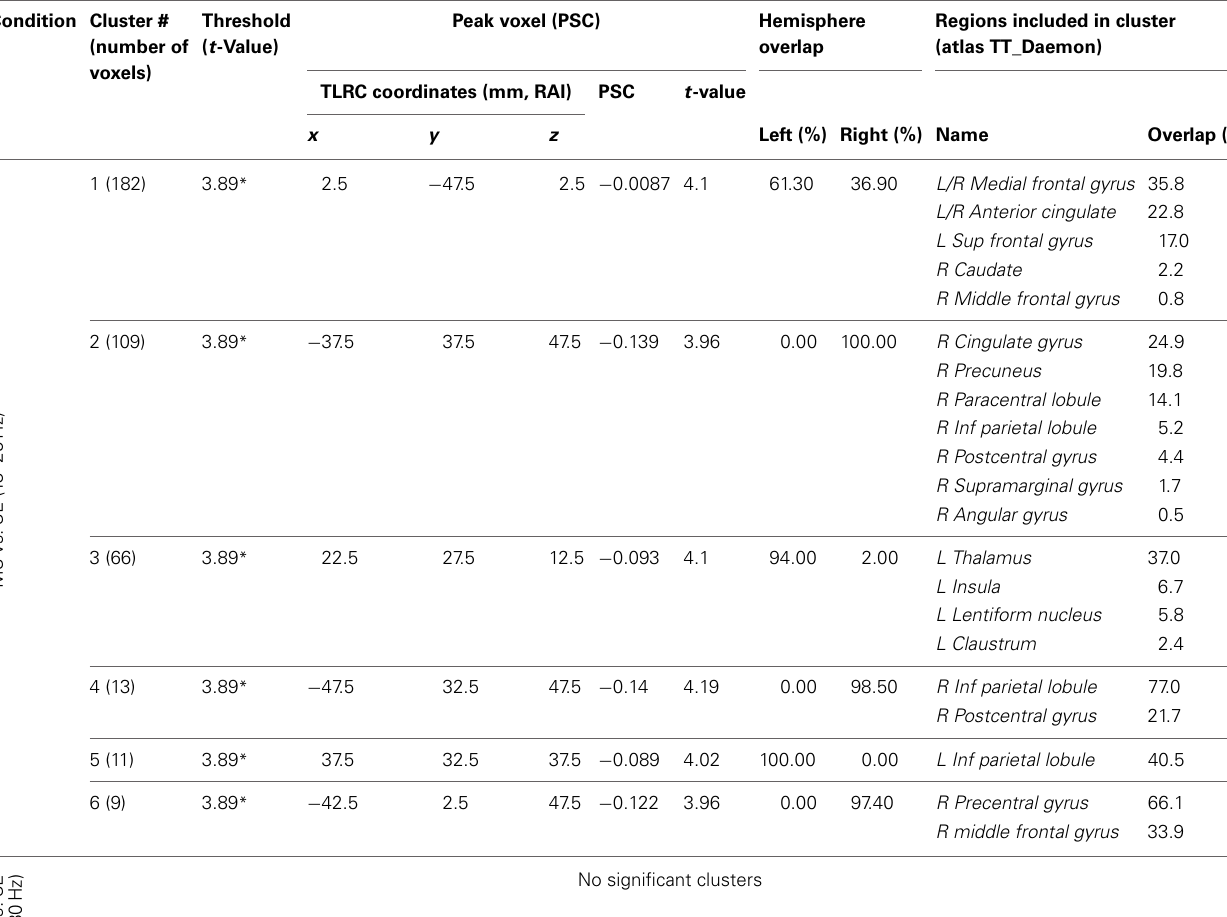
Table 3 | MS vs. SL beamforming solutions for gamma (60–80Hz) and beta (13–25Hz). Condition Cluster